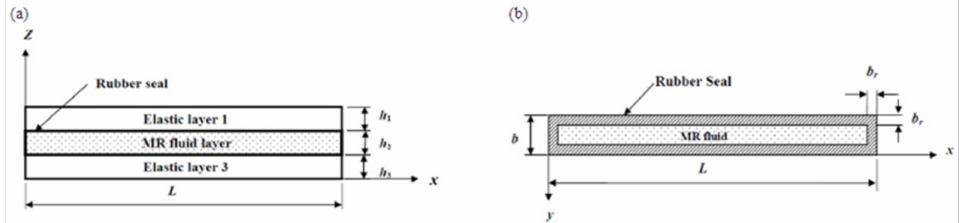
Figure 13. ( a ) MR fluid sandwich beam; ( b ) Plane view of MR fluid layer